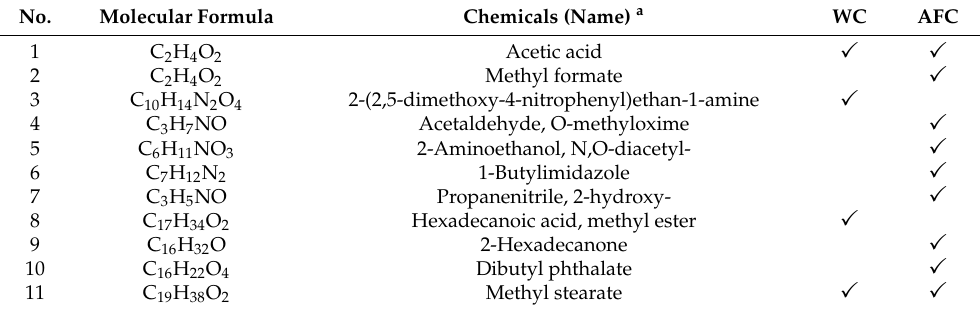
Table 5. GC-MS test results for AFC samples (Fe 3 O 4 /LaNiO 3 ) and WC samples (Blank experiment).